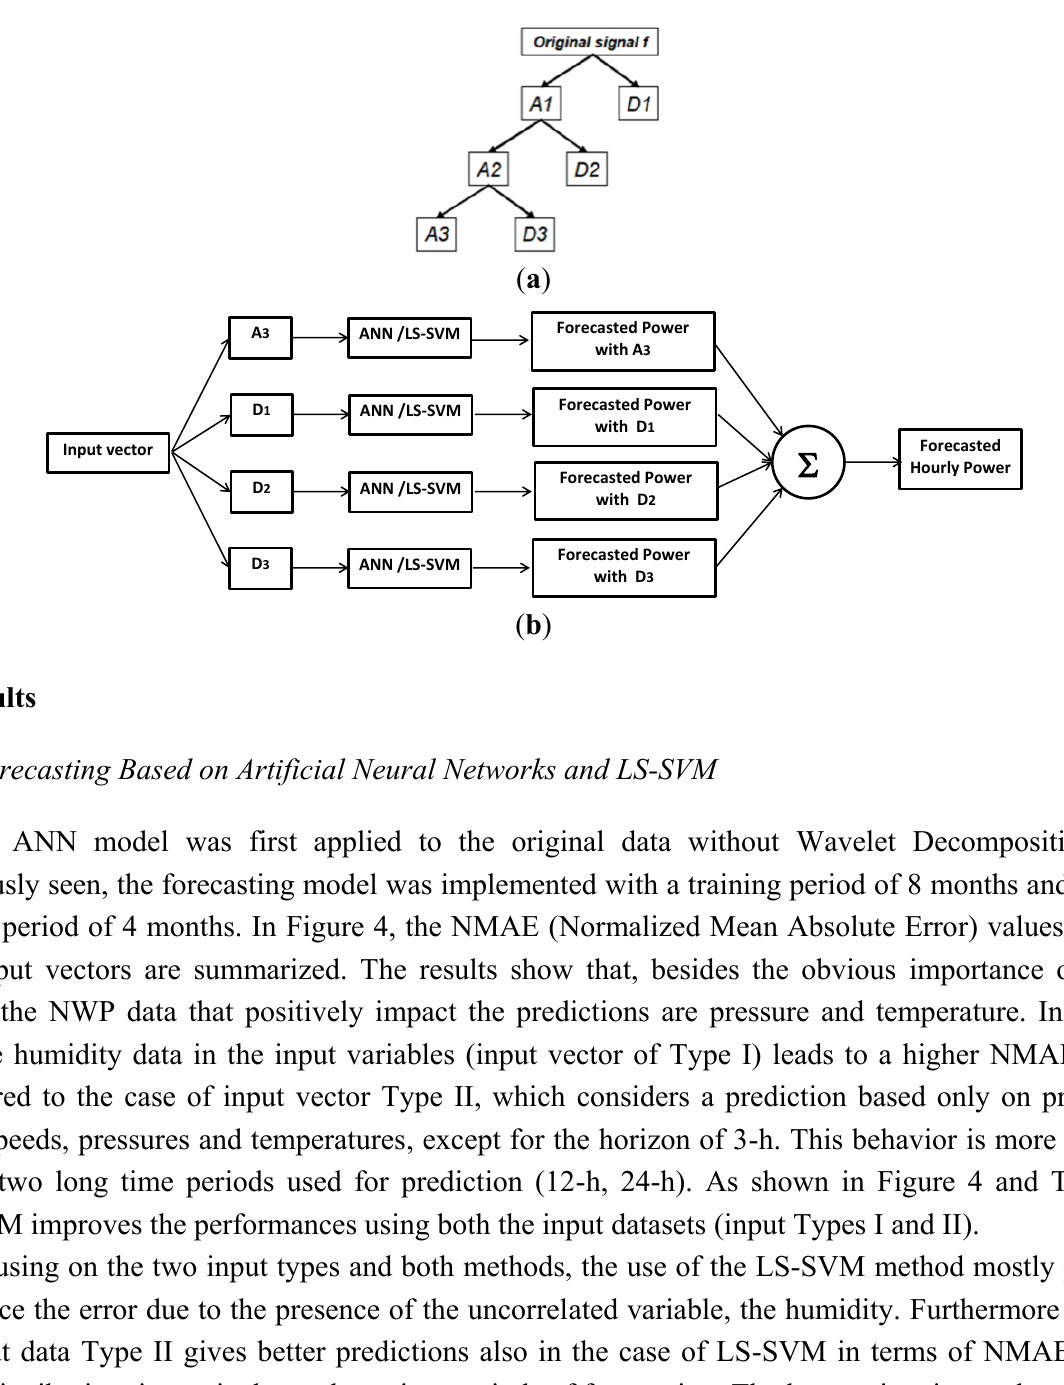
Figure 3. ( a ) Multilevel decomposition process: A and D stand for approximation